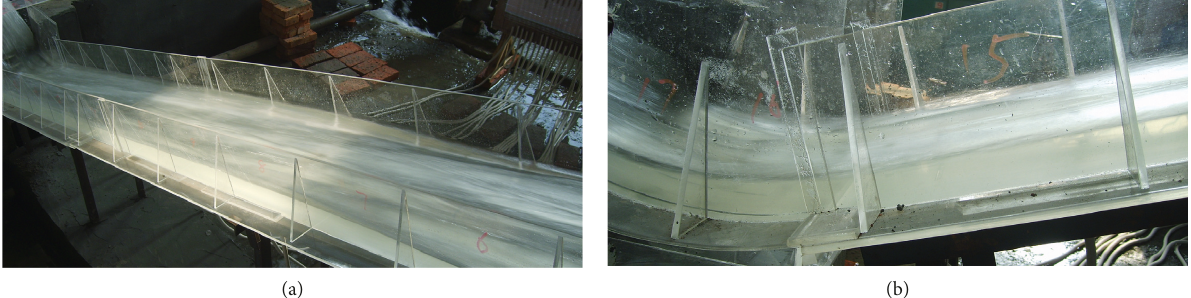
Figure 4: Experimental model of the open spillway. (a) Main chute and (b) flip bucket.